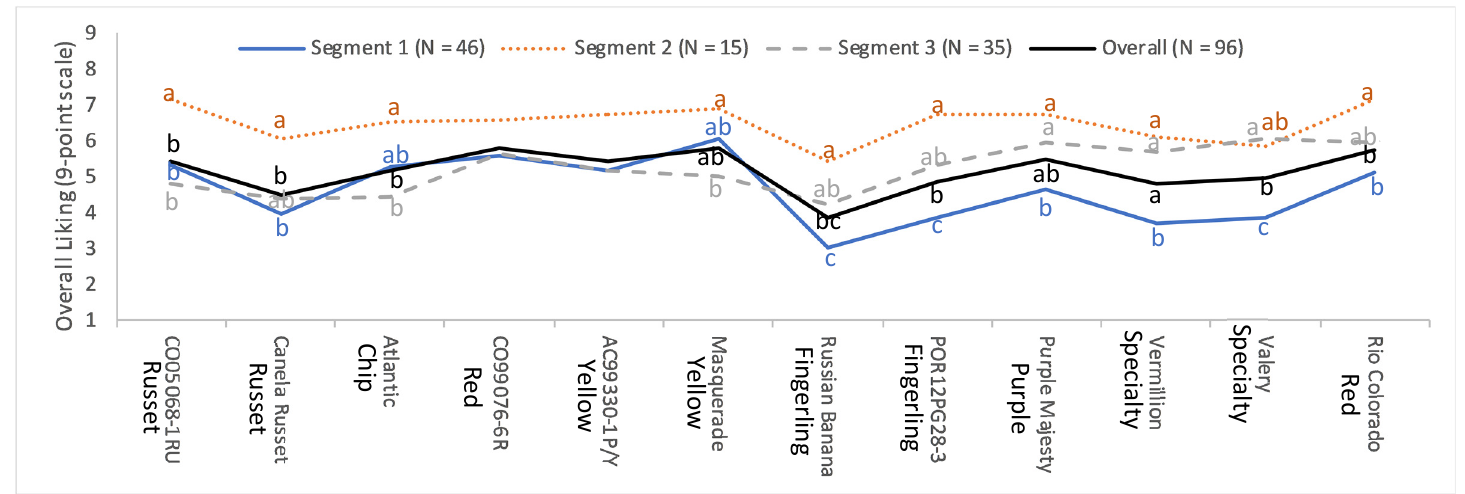
Figure 1. Plot of discovered segments with respect to overall liking score of consumers. Under the null hypothesis of no difference between obtained segments, graphic points with different superscripts implies significant difference within the cultivars ( p < 0.05). Tukey-Kramer was used as post-hoc analysis for pairwise comparison.